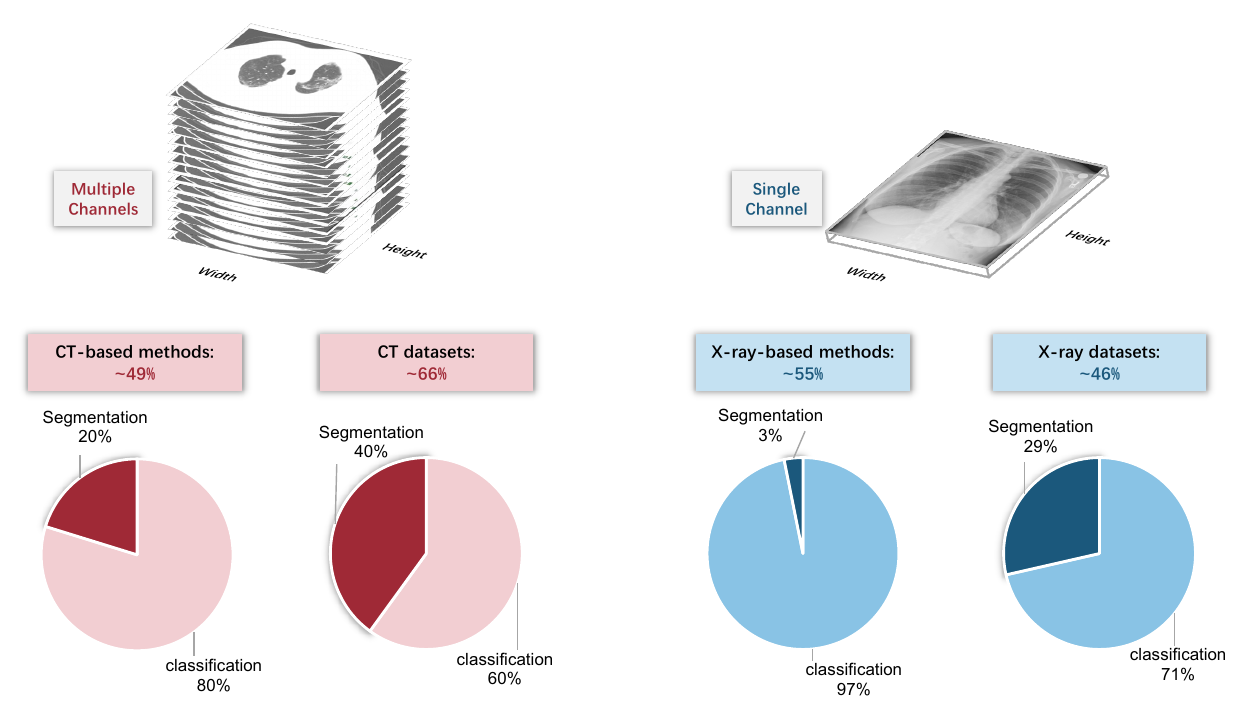
Figure 3. Top : CT image contains multiple channels, whereas X-ray image only has a single channel. Bottom : the proportion of CT/X-ray-based methods and